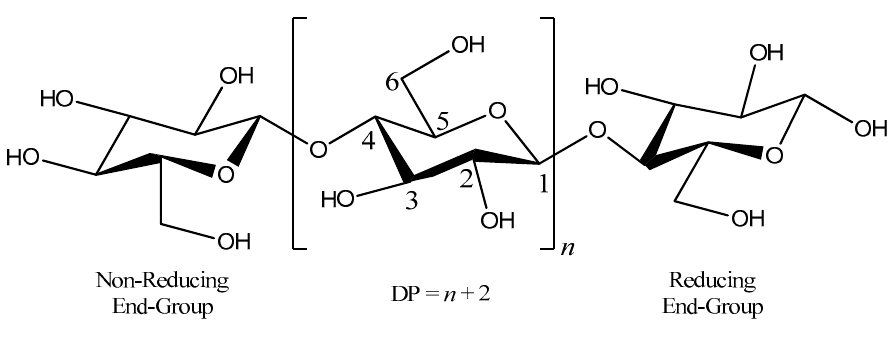
Figure 1. Cellulose structure.